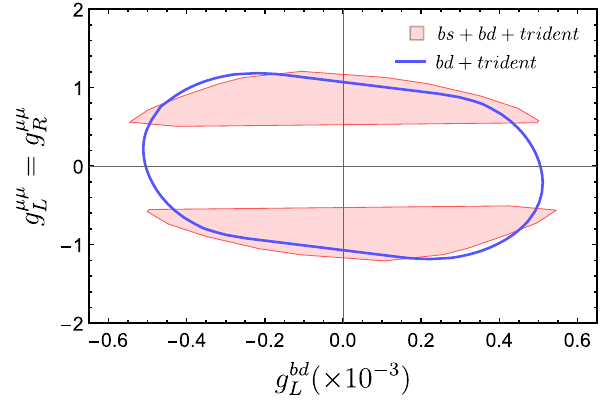
, g μμ ) parameter space corresponding to a Z (cid:3) model Fig. 1 The ( g bd L L μμ = g μμ = 0), for M = 1 TeV. The blue with g (i.e. C bd , NP Z (cid:3) L R 10 curve is the boundary of the 1 σ -favored region due to constraints from measurements in b → d sector and neutrino trident production. The pink shaded region represents the 1 σ -favored parameter space after including additional constraints from b → s μ + μ − data and B s − ¯ B s